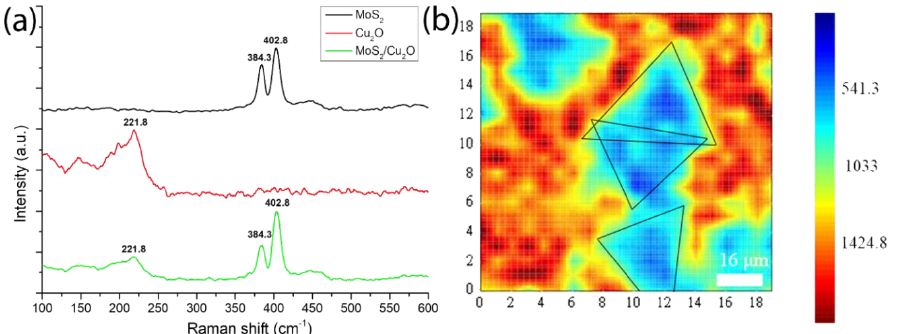
Figure 7. ( a ) Raman spectrum after MoS 2 transfer to Cu 2 O surface and ( b ) Raman mapping of MoS 2 /Cu 2 O. MoS 2 /Cu 2 O.